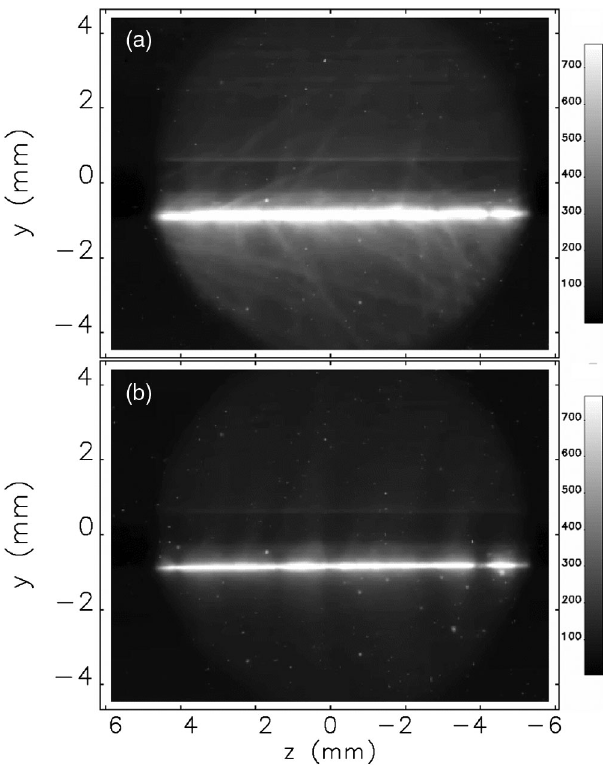
FIG. 19. Emission images at 200 mA from two beam dumps at the same y-offset location; referring to Table VI these strikes are (a) SN11 and (b) SN12. A reduction in light intensity is evident in the second strike.